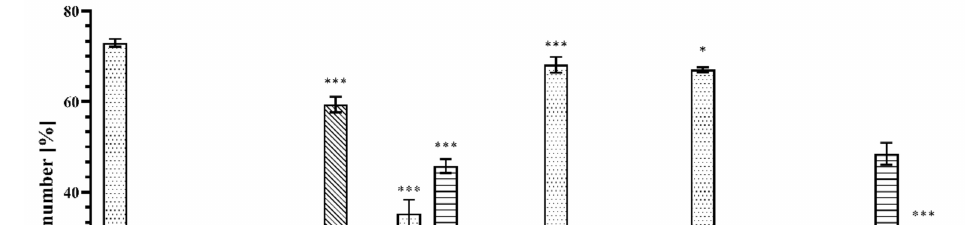
Figure 4. Percentage of accumulation C32 melanoma cells in the different cell cycle phases after 24 h of incubation with JM4 (25, 50, 100 µ g/mL), 22 (25 µ g/mL) and vinblastine sulfate (VLB) (25 µ g/mL). Mean percentage from three independent experiments ( n = 3) done in duplicate are presented. * p < 0.05 versus control group, ** p < 0.01 versus control group, *** p < 0.001 versus control